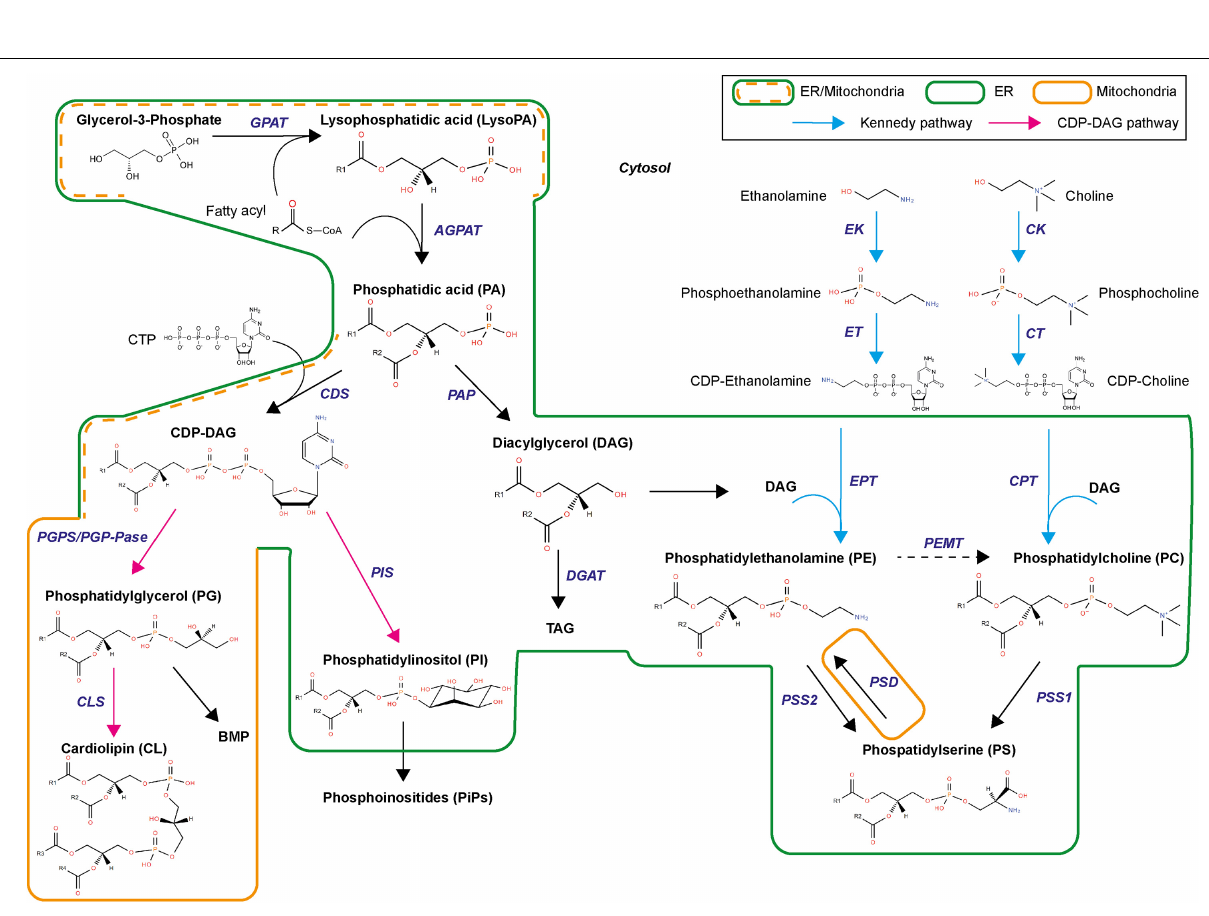
FIGURE 4 | Biosynthetic pathways for phospholipids. GPAT, glycerol-3-phosphate acyltransferase; AGPAT, 1-acyl-sn-glycerol-3-phosphate O-acyltransferases; CDS, CDP-diacylglycerol synthase; PGP, PG phosphate synthase, CLS, cardiolipin synthase, PIS, PI synthase; PAP, PA phosphatase; DGAT, Diglyceride acyltransferase; EK, ethanolamine kinase; CK, choline kinase; ET, triphosphate:phosphoethanolamine cytidylyltransferase; CT, triphosphate:phosphocholine cytidylyltransferase; EPT, DAG:CDP-ethanolamine ethanolaminephosphotransferase; CPT, DAG:CDP-choline cholinephosphotransferase; PEMT, PE methyltransferase; PSD, PS decarboxylase; PSS1, PS synthase 1; PSS2, PS synthase 2.